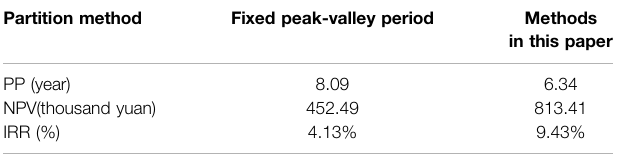
TABLE 8 | Results of economic indicators.